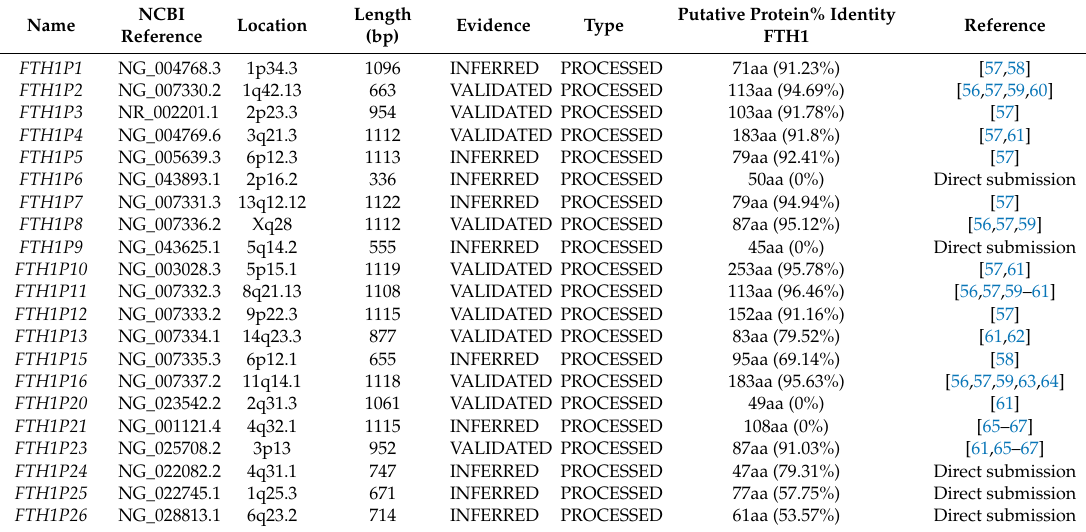
Table 1. Features of FTH1